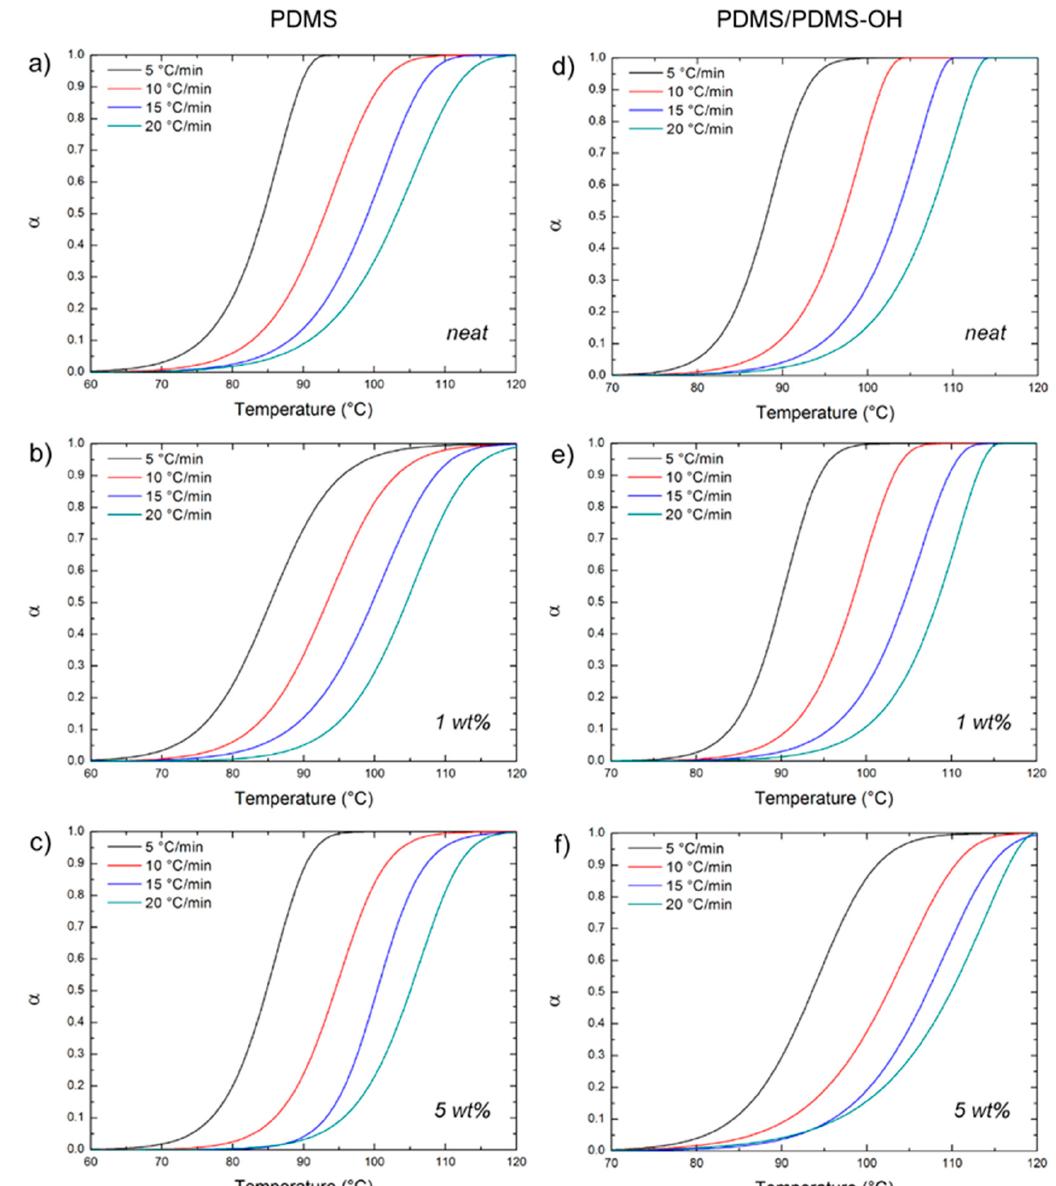
Figure 4. Extent of conversion ( α ) as a function of temperature for the nanocomposites with PDMS (Sylgard 184) and the PDMS/PDMS–OH (75:25 w/w) matrix at different heating rates: ( a , d ) unfilled; ( b , e ) filled with 1 wt% GNP–DNA; ( c , f ) filled with 5 wt% GNP–DNA.